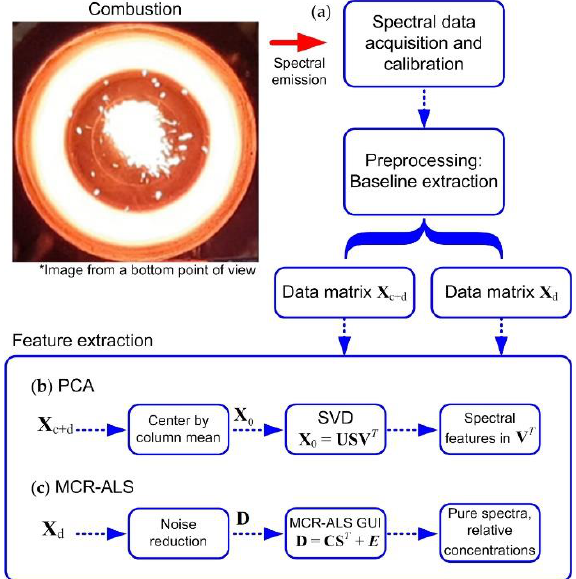
Figure 2. Data acquisition and analysis pipeline. ( a ) Spectral data acquisition and preprocessing. ( b ) Principal component analysis (PCA) features extraction. ( c ) Multivariate curve resolution method alternate least squares (MCR-ALS) application for separation of pure spectral signals. Note that the depicted combustion image is only for visualization purposes, and the optical fiber is located at the central centered position.